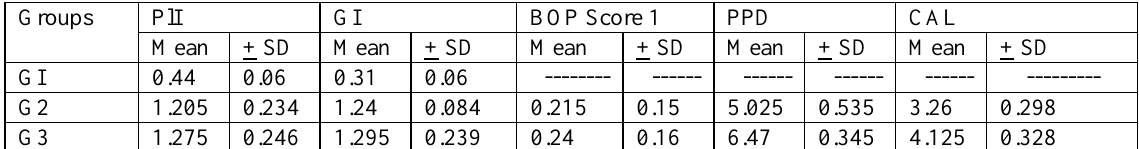
Table 1: describe mean and standard deviation for the periodontal parameters of the three groups